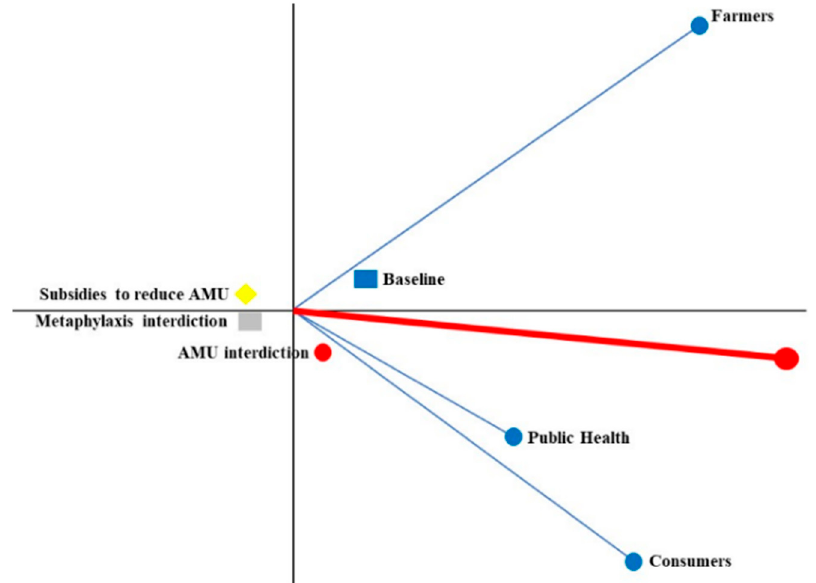
Figure 2. Aggregated decision map (GAIA plane) of decision makers considered in this study. (Delta = 96.6%; 96.6% of the information is conserved in the two-dimensional representation of this map).